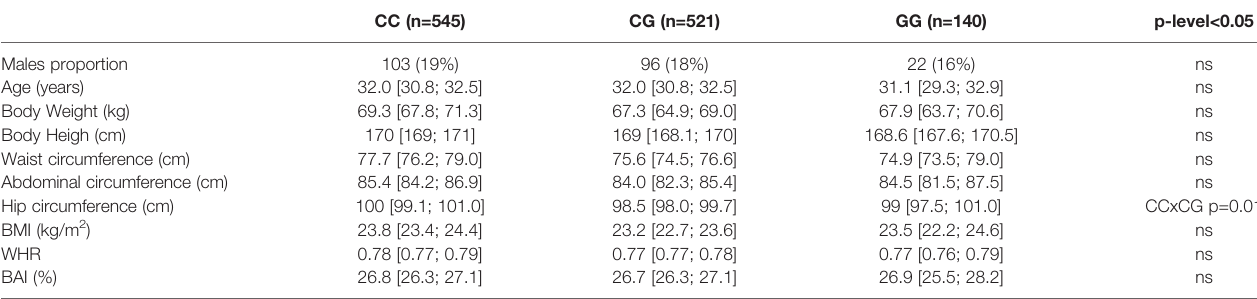
TABLE 1 | Anthropometric characteristics depending on the MTNR1B rs10830963